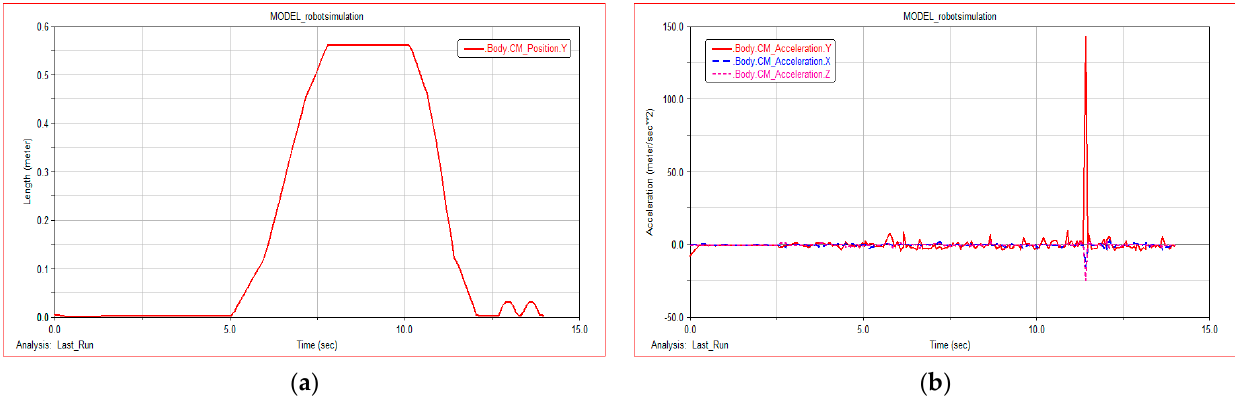
Figure 11. Simulation result of moving in slope terrain: ( a ) robot centroid displacement; ( b ) robot centroid acceleration.